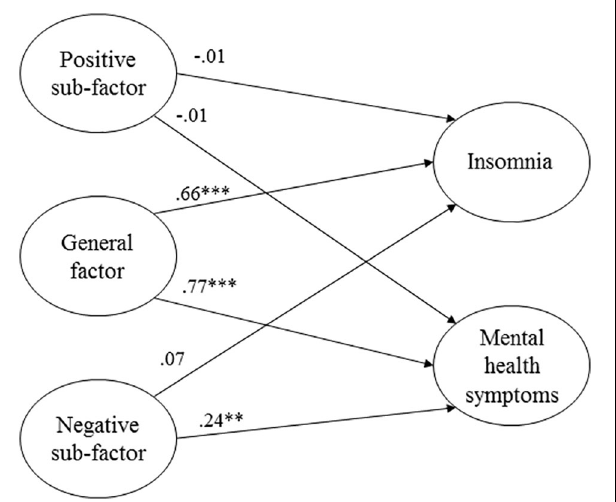
FIGURE 2 | Structural model with the general GHQ-factor and two specific sub-factors predicting symptoms of insomnia and mental health ( χ 2 = 368.737, p < 0.001, CFI = 0.92, SRMR = 0.048, RMSEA = 0.069, 90% confidence interval for RMSEA = 0.061 – 0.077). Regression weights are standardized coefficients. *** p < 0.001. ** p <